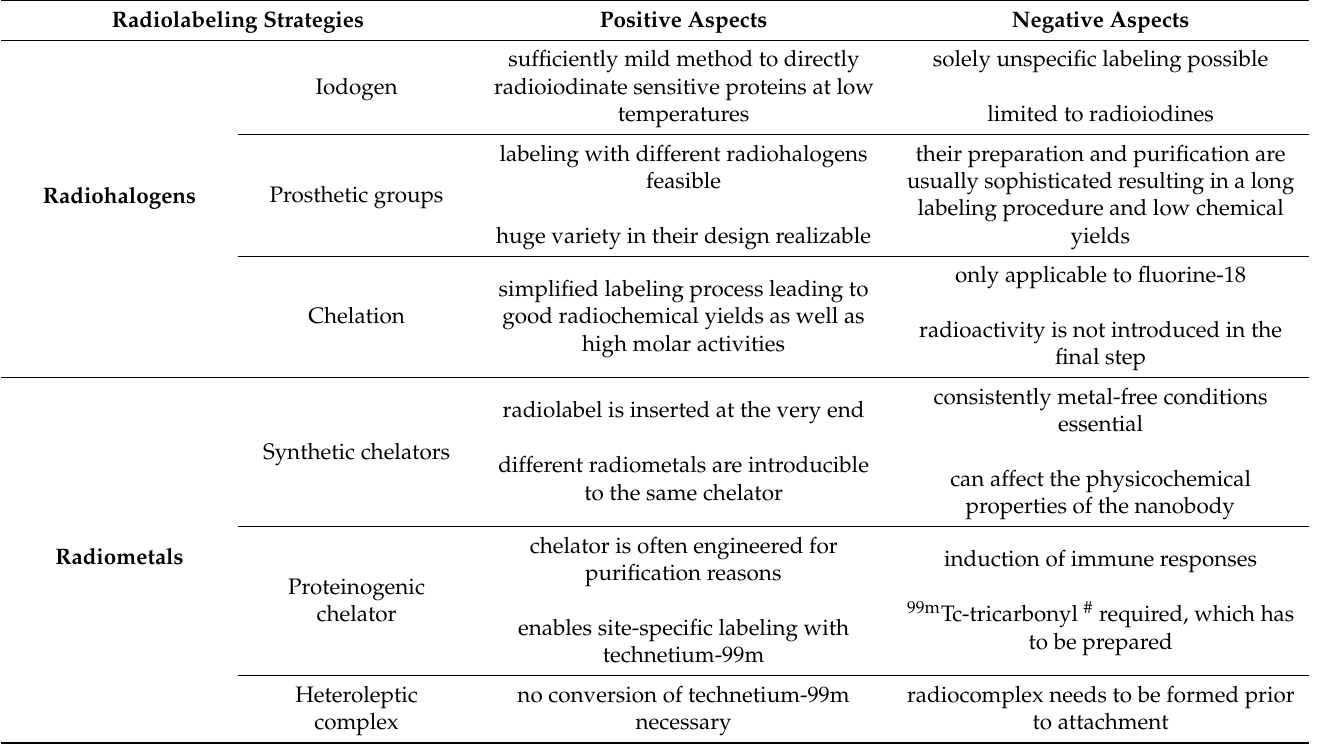
Table 1. Pros and Cons of the herein discussed radiolabeling techniques applied to nanobodies. Radiolabeling